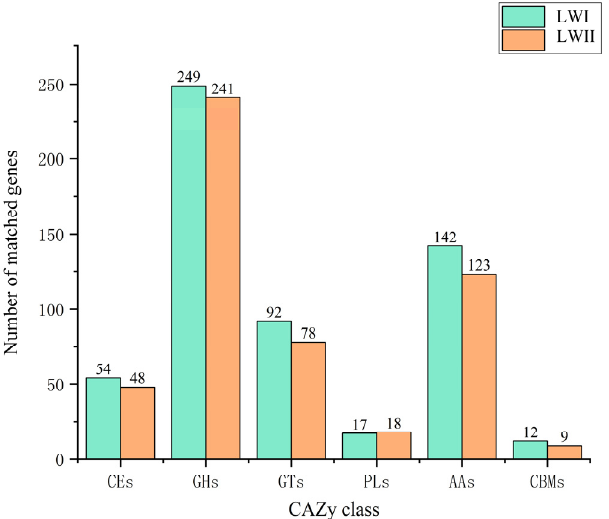
Figure 9. Carbohydrate-active Enzymes Database (CAZy) annotation results of E. rostratum LWI and B. zeicola LWII.